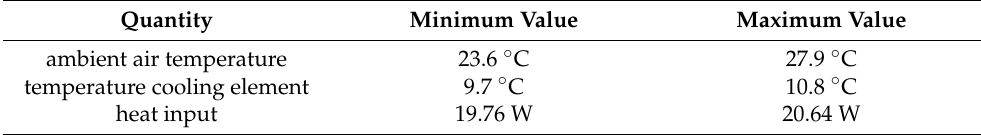
Table 2. Varying parameters with the respective